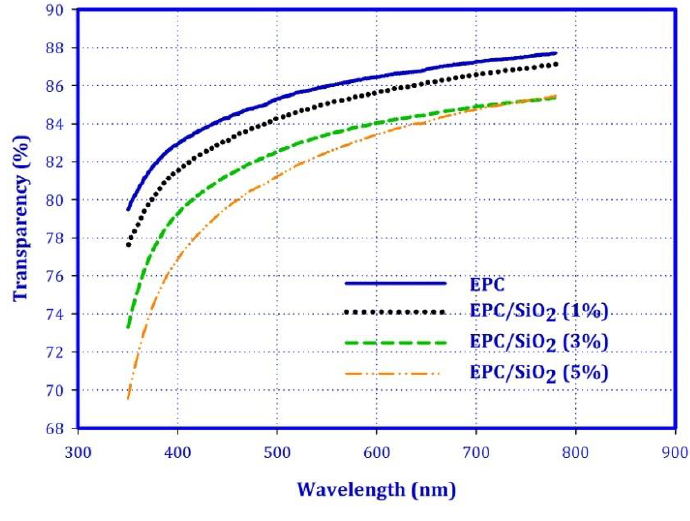
Figure 6. Transmittance spectra for the EPC and its nanocomposites.